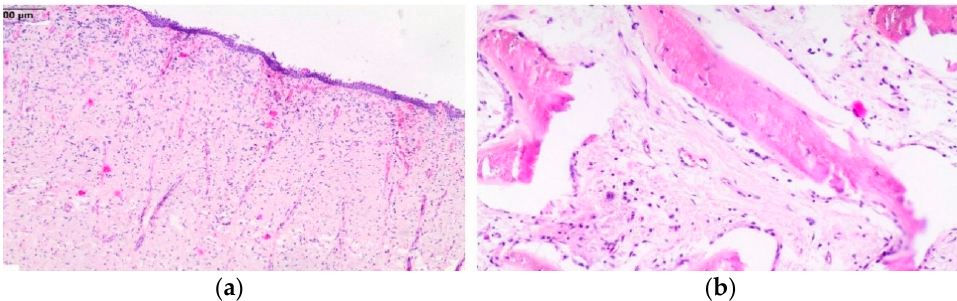
Figure 10. Histological section of the mass. Benign proliferation of fibrous connective tissue superficially ( a ); curvilinear trabeculae of woven bone set in a fibrous stroma in deeper parts of the mass ( b ).